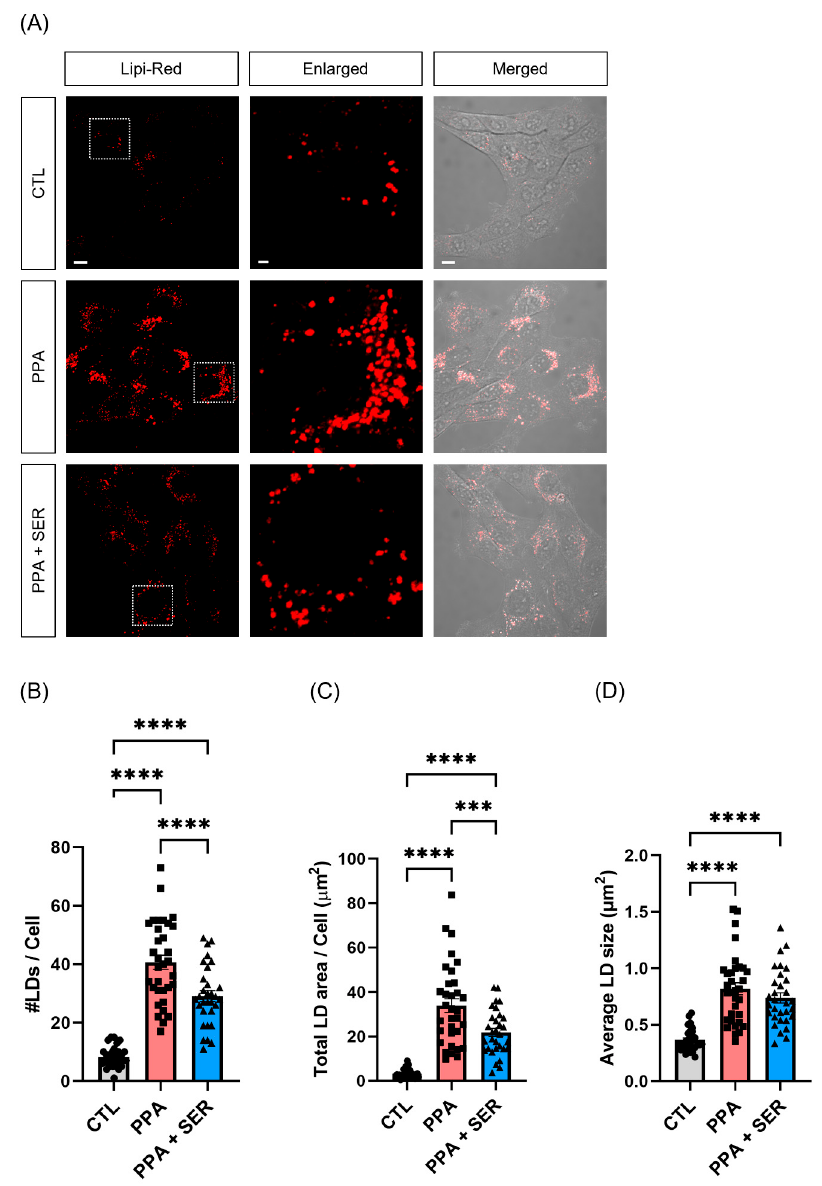
Figure 3. PPA induced lipid droplet (LD) accumulation in HT22 cells. Cells were treated with 5 mM PPA only or 5 mM PPA and 10 mM L-serine (SER) for 48 h. ( A ) Confocal imaging of HT22 incubated with red fluorescence to label lipid droplets. Scale bar, 10 µ m (left, right); 2 µ m (middle, the magnified images). ( B – D ) Quantification of Lipi-red number of puncta ( B ), total area ( C ), and average size ( D ) ( n = 30). *** p < 0.001, **** p < 0.0001 by One-way ANOVA, Tukey’s multiple-comparison